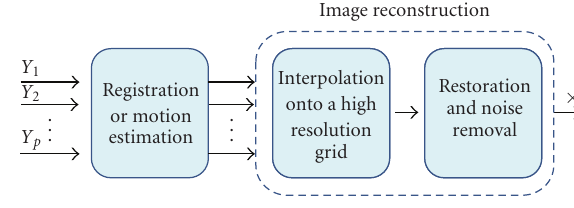
Figure 5: Stages of image super resolution.